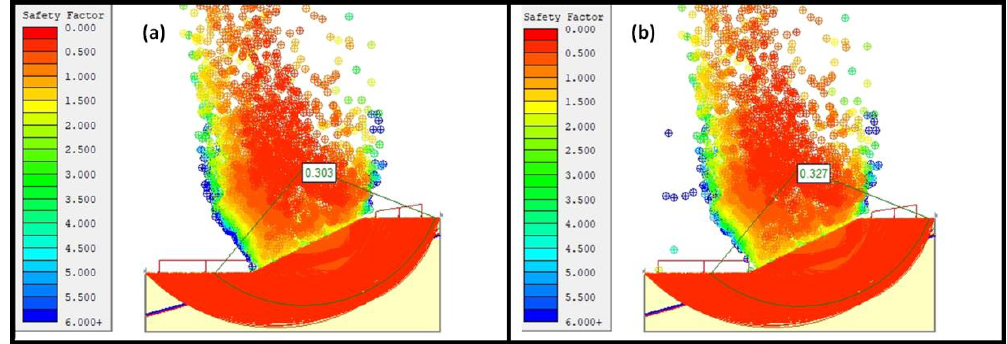
Figure 28. Safety factor simulated for drained to undrained conditions in clay loam soil slope using ( a ) Spencer’s method and ( b ) Corp of Engineers’ Number One method.